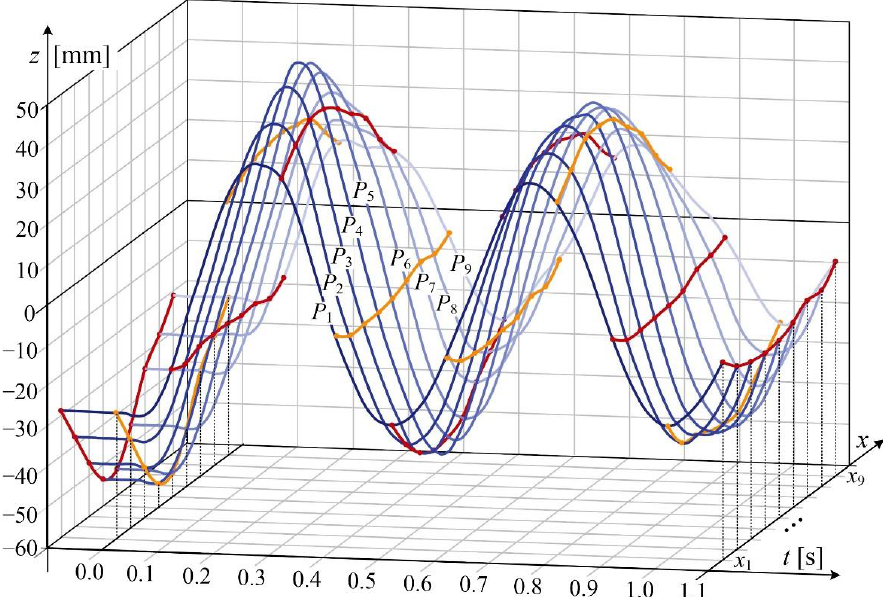
Figure 12. Displacement waveform of LED points. Red and orange lines visible position of the contact wire every 0.1 s.